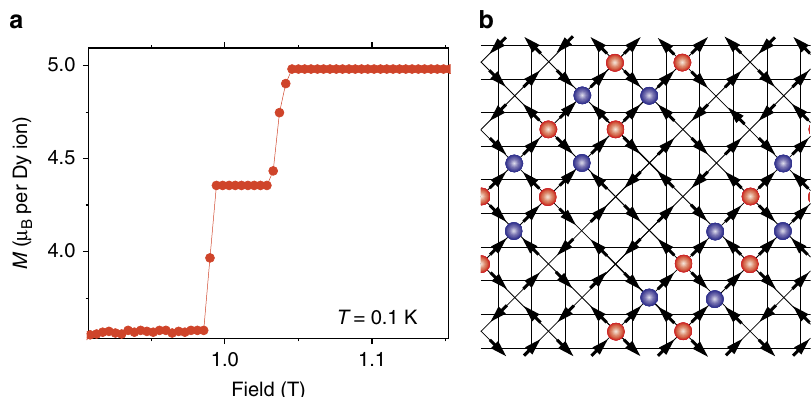
Figure 4 | Plateu in the magnetization and intermediate state of the model with distortions (d-DSM). ( a ) The simulated magnetization curve in a homogeneous system as a function of field for T ¼ 0.1K with the field at an angle of (cid:3) 5 (cid:2) from [111]. A mid-plateau is stabilised between the kagome-ice and the fully polarized state. ( b ) A sketch of this intermediate state projected along [100]. The coloured circles mark tetrahedra where the ice-rule is broken either by excess (blue) or defect (red) of inward